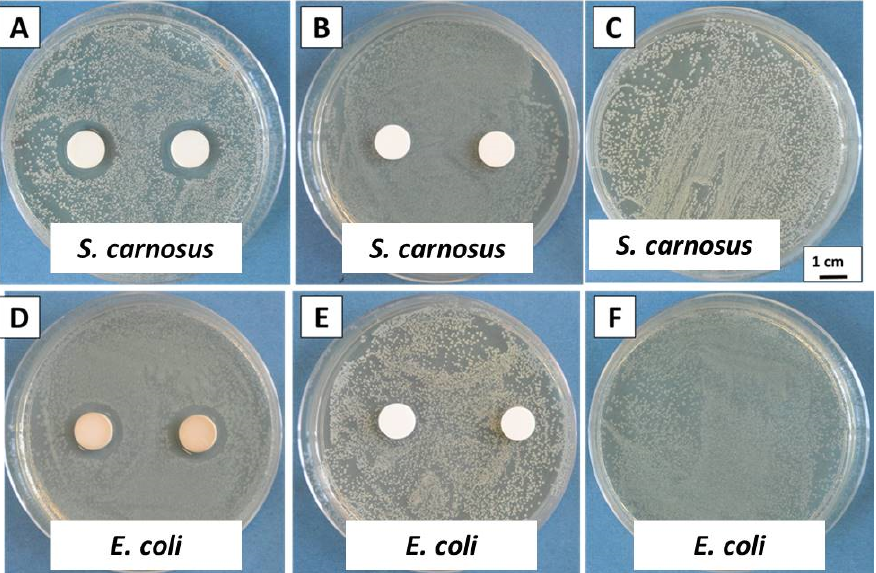
Figure 7. Inhibition halo tests with S. carnosus for ( A ) Ag-Sr MBGNs, ( B ) MBGNs, ( C ) reference sample and with E. coli for ( D ) Ag-Sr MBGNs, ( E ) MBGNs, ( F ) reference